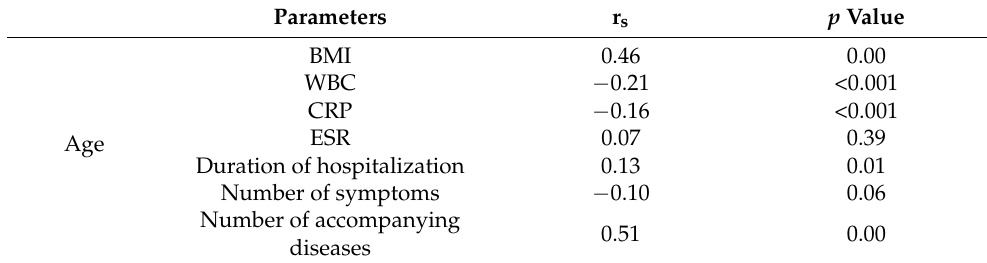
Table 4. Correlations between age and BMI, WBC, CRP, ESR, duration of hospitalization, number